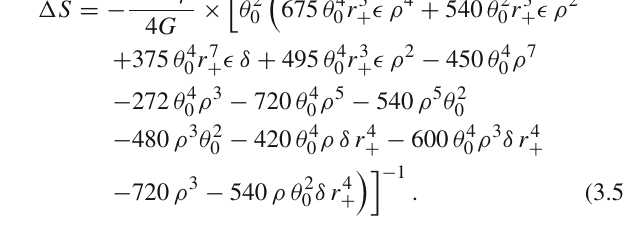
region of the boundary in RNSAdS is then given by Eq. (2.8)